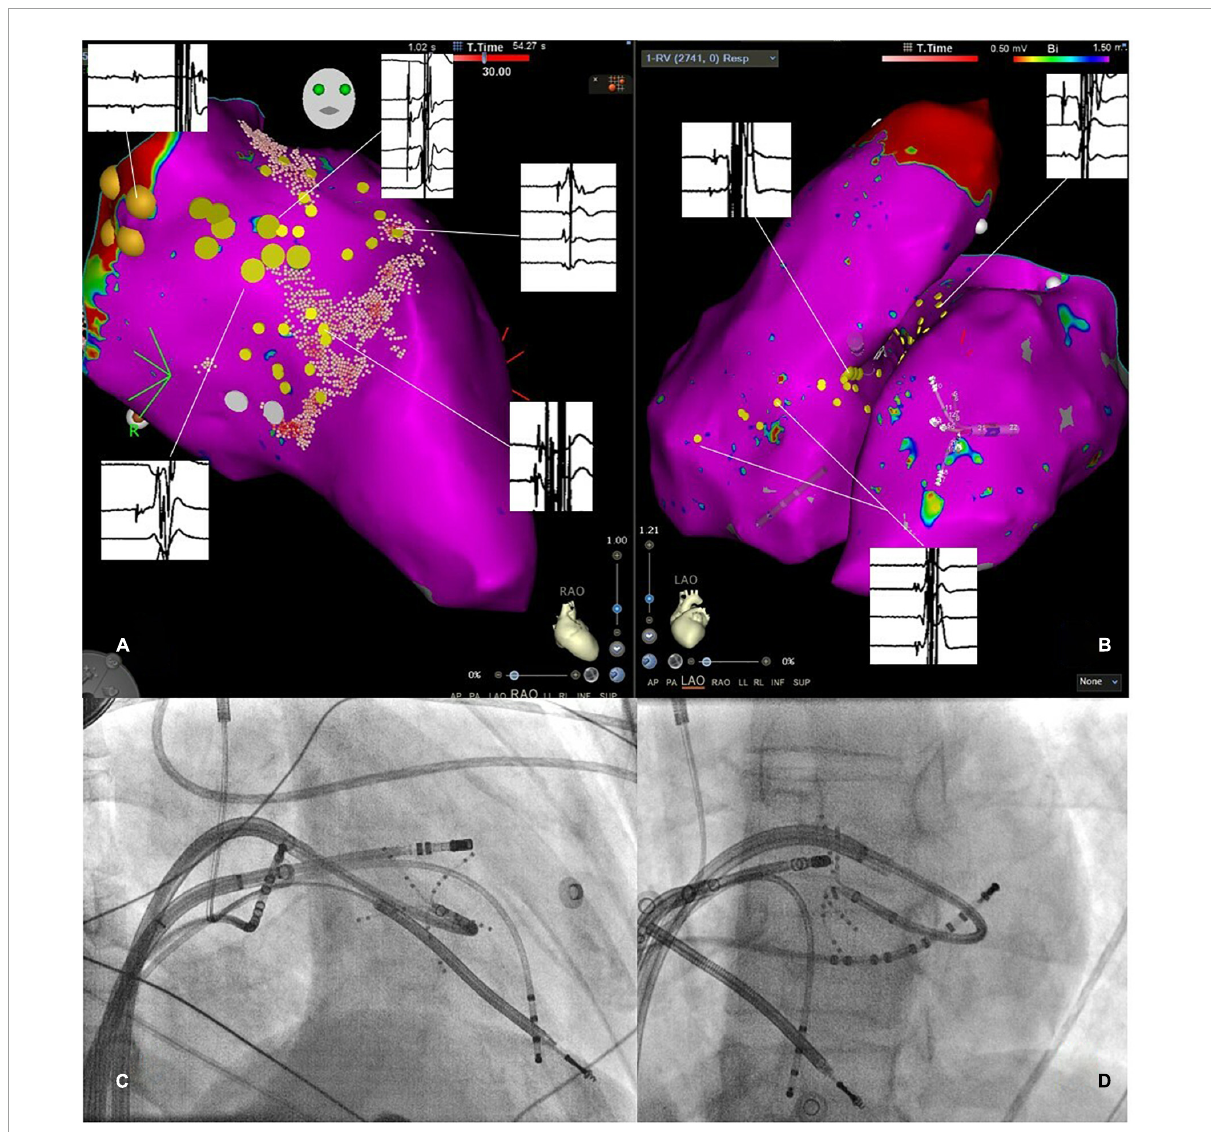
FIGURE3 (A) Three-dimensional electroanatomic mapping of the left ventricle (LV) in right anterior oblique projection. The specific conduction system has been marked by large yellow tag points representing the His-bundle region and the left anterior fascicle. Regions with distinct Purkinje potentials were marked with small yellow tag points. Representative electrocardiograms are shown and linked to the specific location of the recording. Notably, clear Purkinje potentials are observed. (B) Three-dimensional electroanatomic map in the left anterior oblique view of the RV and LV with small yellow tag points placed at regions with Purkinje potentials. Exemplary electrograms are linked to the specific site of a recording showing clear Purkinje potentials. (C,D) Show fluoroscopic catheter-set up in the right anterior oblique and left anterior oblique view consisting of a multipolar mapping catheter at the LV septum, two diagnostic catheters placed in the RV and the coronary sinus as well as an ablation catheter in the